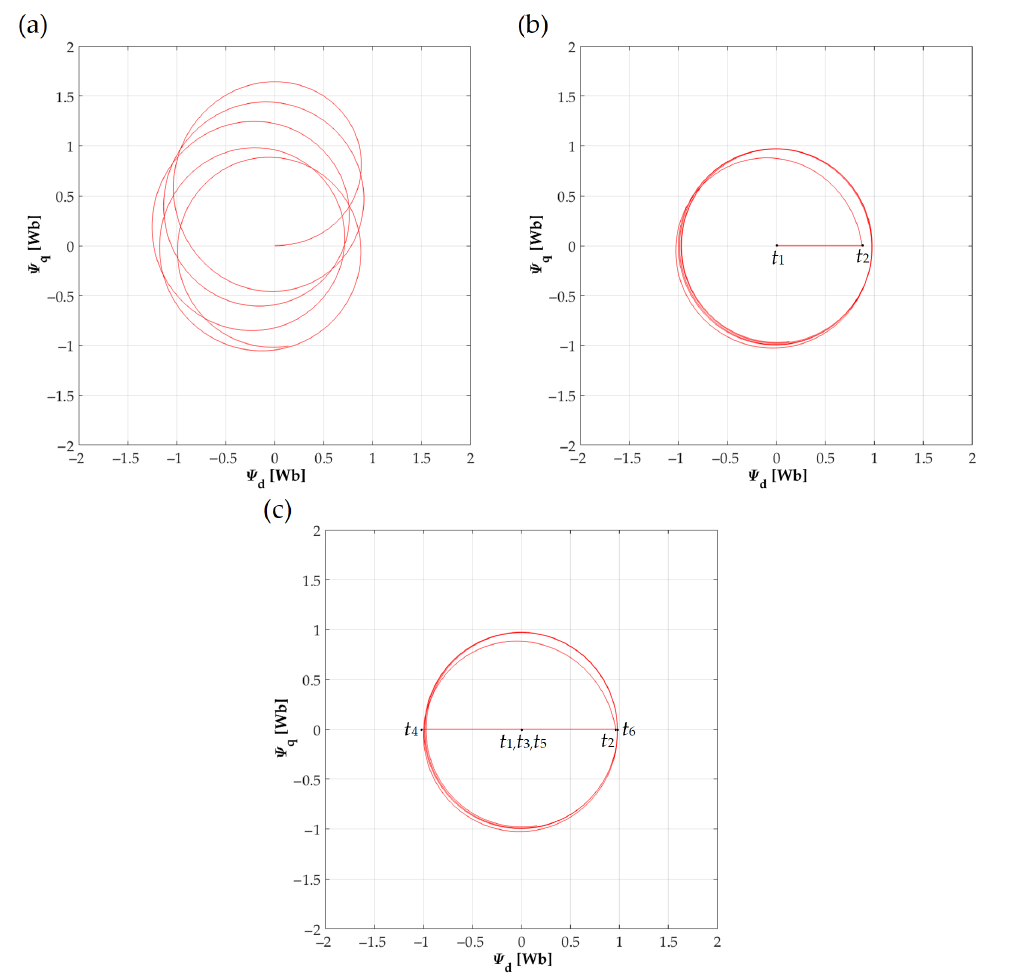
Figure 4. Hodograph of the magnetic flux in the d-q orthogonal system, where: ( a ) for the direct start-up; ( b ) for the new direct start-up, with a voltage delay of one phase voltage equal to 5 ms; ( c ) for the new direct start-up, with a voltage phase switching delay of 25